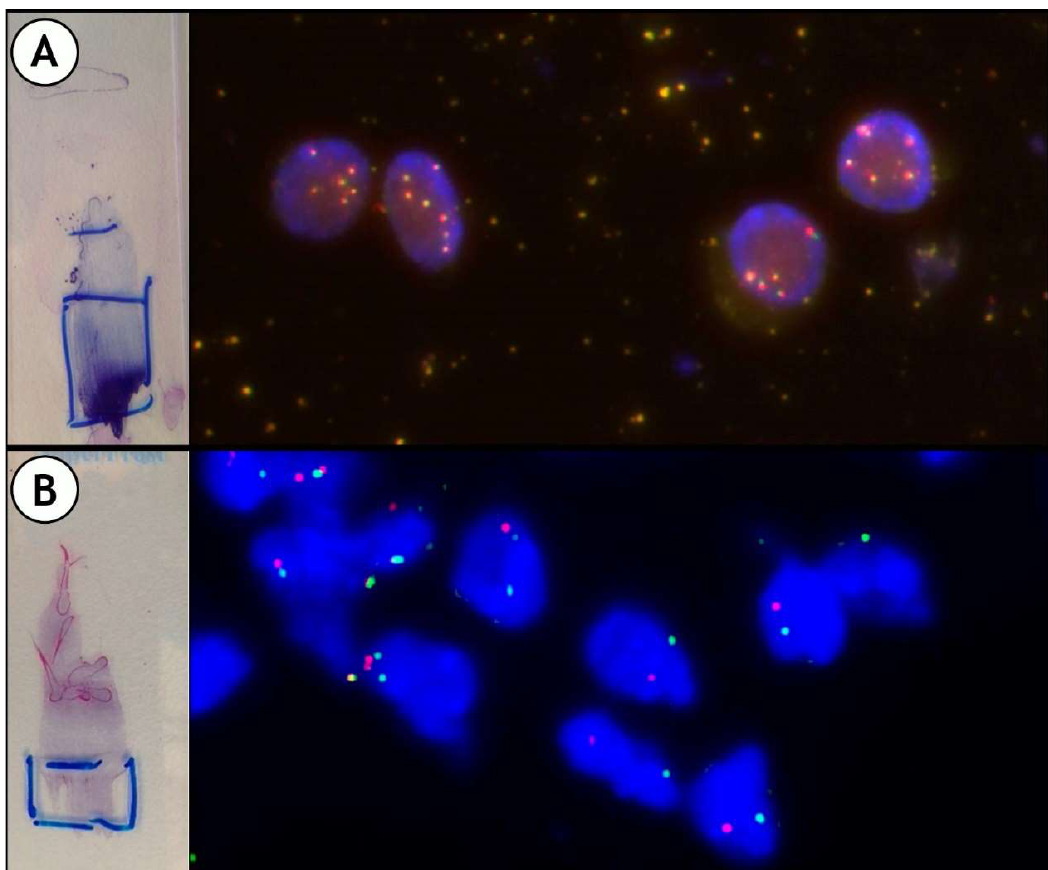
Figure 7. Some examples of Fluorescence In Situ Hybridization (FISH): A : ALK polysomic; B : and ROS1 rearranged. Split of green and red signals.